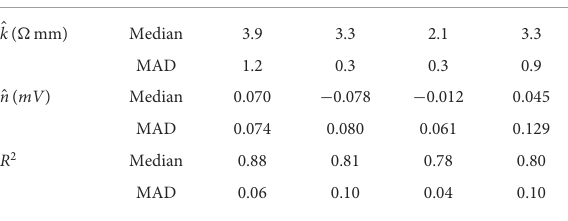
TABLE 3 Median and median absolute deviation (MAD) values for dipole model parameters and R-squared values across subjects. Median and MAD are calculated across all stimulation channels in each representative